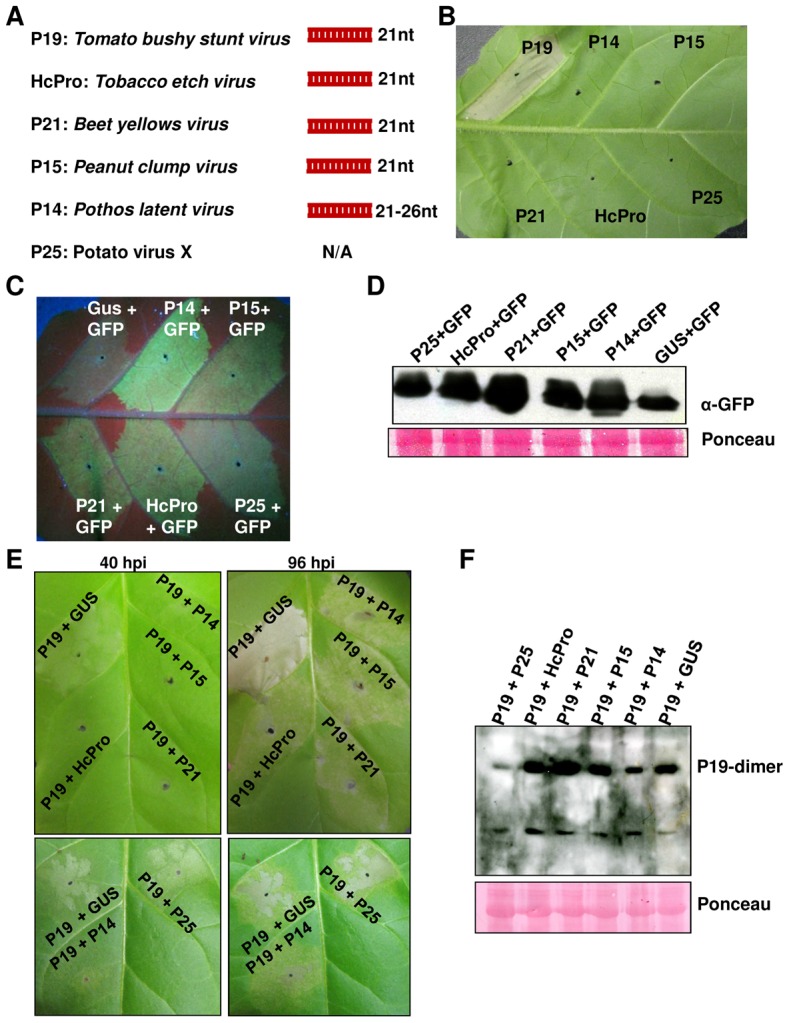
Effects of VSRs unrelated to P19.(A) List of VSRs used in this study alongside their preferential sRNA binding sizes, as established in vitro. P25 is unable to bind sRNAs in vitro. Leaves of five week-old N. tabacum cv. Xanthi were transiently infiltrated with Agrobacterium tumefaciens expressing either P19, P14, P15, P21, P25 or HcPro. (B) HR response as evaluated 5 days post infiltration of the various VSRs lsited in (A). (C–D) Leaves of N. tabacum cv. Xanthi were infiltrated with a mixture of Agrobacteria containing either P14, P15, P21 or HcPro together with a GFP transgene used as a visual and molecular reporter of the onset of RNA silencing in the co-infiltrated tissues. GFP fluorescence was visualized 4 days post-infiltration under UV light (C) and by Western analysis using an anti-GFP antibody (D). Ponceau staining of the same extracts is depicted to demonstrate equal protein loading. (E) Leaves of five week-old N. tabacum cv. Xanthi were infiltrated with A. tumefaciens strains expressing P19 in combination with either P14, P15, P21, HcPro, P25 or the GUS reporter gene. Appearance of P19-triggered HR lesions was monitored at 40 hpi (Left panel) and 96 hpi (Right panel). Experiments were repeated three times with similar results. (F) Western analysis of P19 protein levels in P19-VSR co-treatments. Proteins extracts from P19-VSRs or P19-GUS co-treated leaves were subjected to anti-P19 immunoblotting after 48 h. Ponceau staining of the membrane is shown to demonstrate equal protein loading. Experiments were repeated three times and showed similar results.